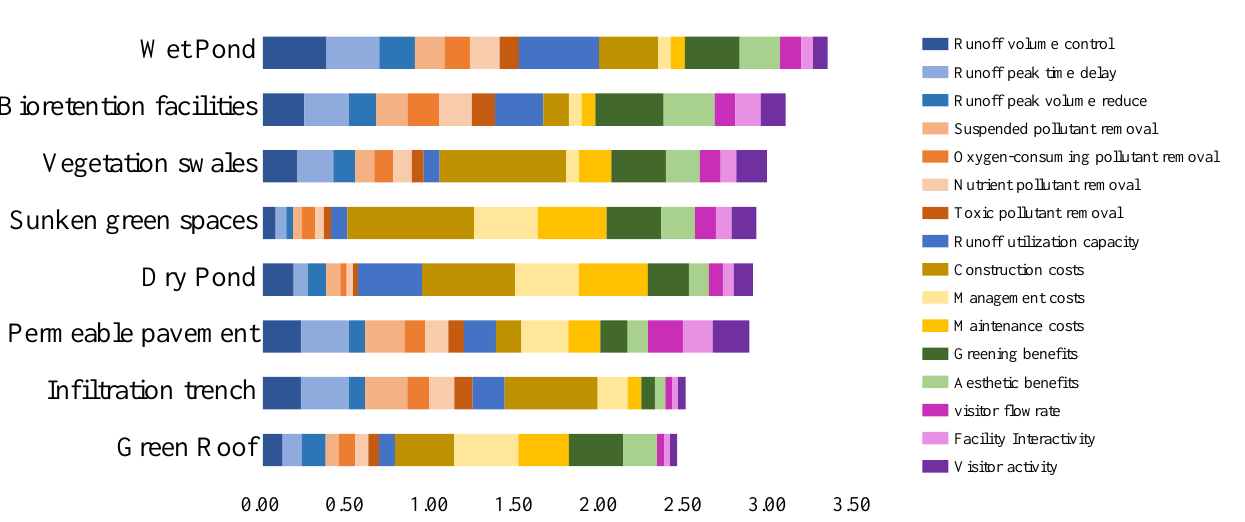
Figure 4. Ranking for weighted multi-functional effectiveness combined score.